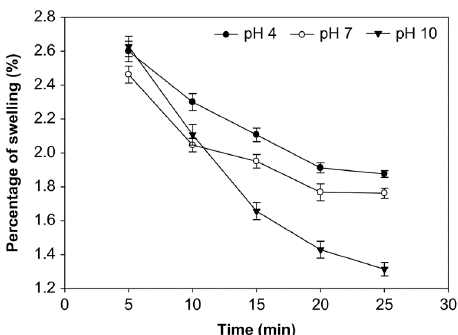
Figure 10. The effect of time on swelling power at various pH with the starch concentration of 10% ( v / w ).